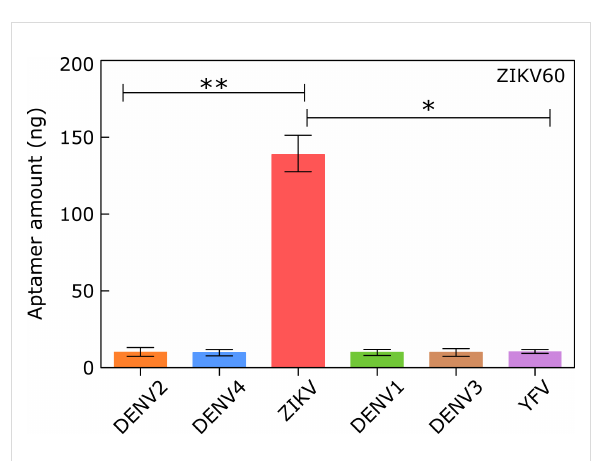
After the third selection cycle, the obtained ssDNA pools were cloned and sequenced. Seventy-five sequences were identified.